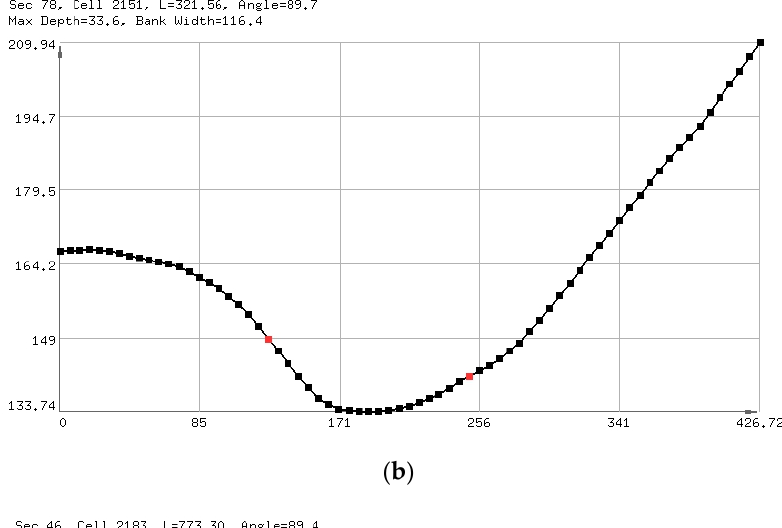
Figure 35. Representative sections of the first set. Sections 89 ( a ), 78 ( b ) & 46 ( c ).